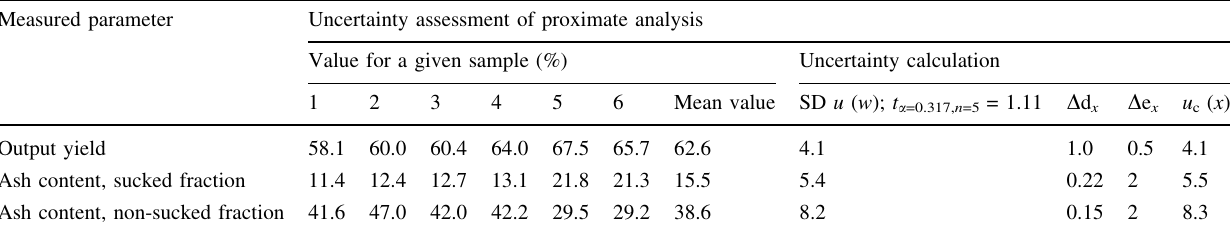
Table 13 Results of laboratory tests together with the calculated measurement uncertainties (coal samples in the grain-size class of 6–25 mm) Measured